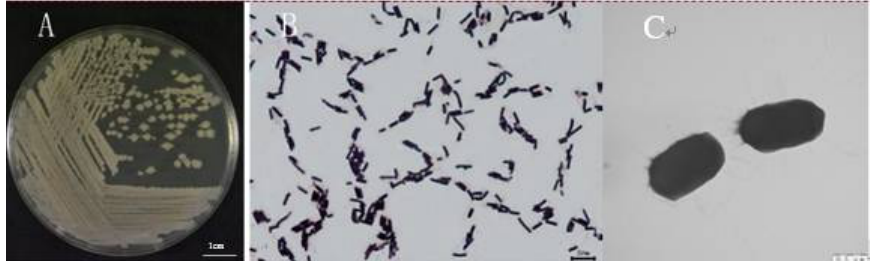
Figure 2. Morphological characteristics of strain WXCDD105 on LB medium plate culture ( A ), and observed under an optical microscopes ( B ) and transmission electron microscopy ( C ).